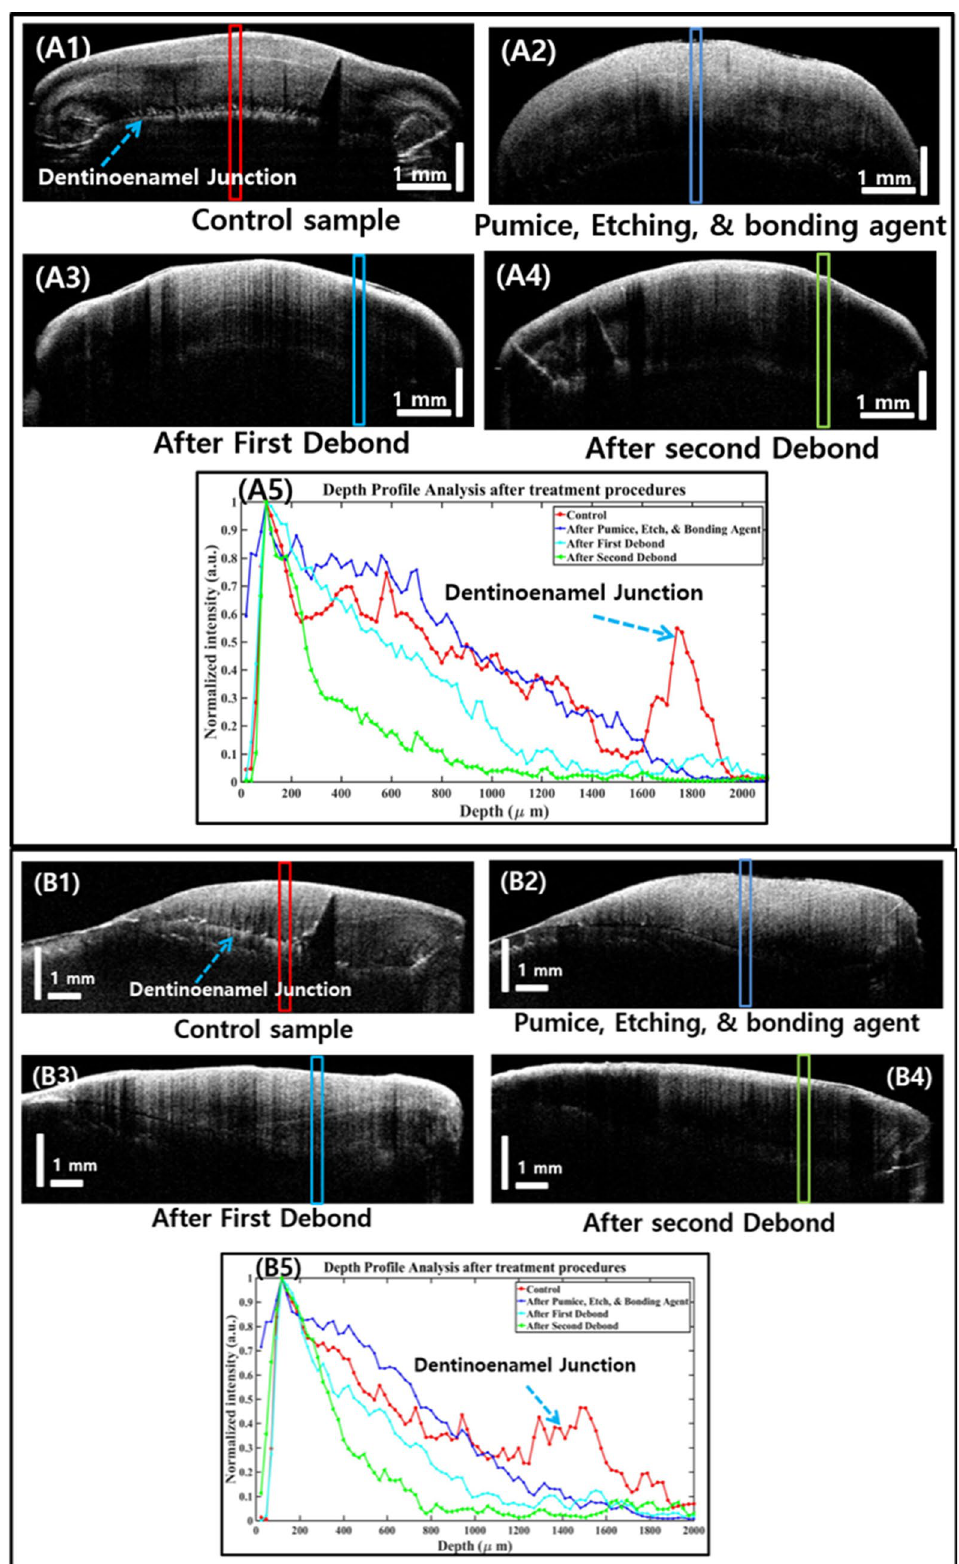
Figure 7. Depth intensity profile analysis of cross-sectional OCT images of the tooth sample after each stage of treatment procedures. ( A1 – A4 ) and ( B1–B4 ) are the cross-sectional OCT images in the axial plane and sagittal plane, respectively. Tooth samples that are taken as control ( A1 , B1 ), after pumice, etching, and bonding agent step ( A2 , B2 ), after first debonding and adhesive remnant cleaning ( A3 , B3 ), and after second debonding followed by adhesive remnant cleaning procedure ( A4 , B4 ). ( A5 ) and ( B5 ) are the depth intensity profile plots of OCT images, respectively. Solid rectangular boxes (red, black, light blue, dark blue, and green) are the regions within which the depth profile analyses are